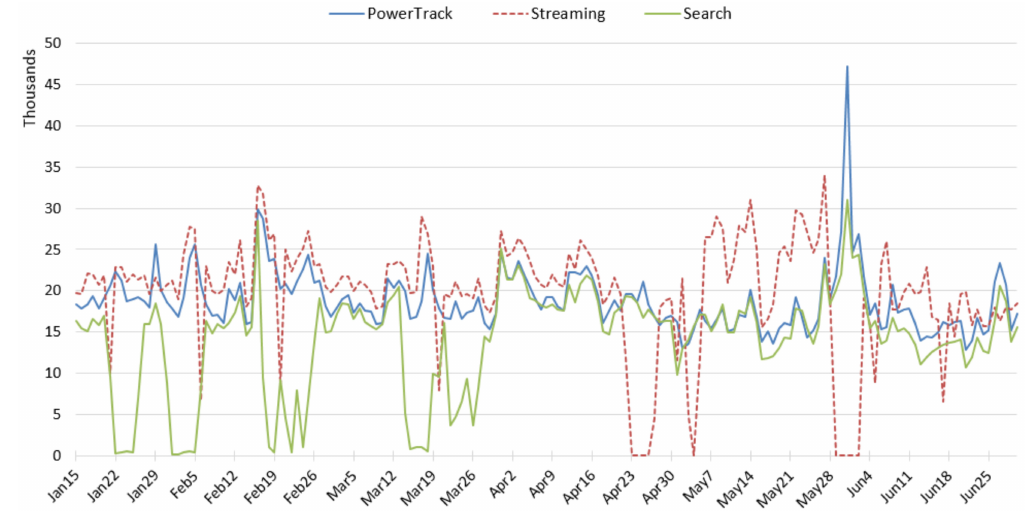
Figure 2. Daily amount of tobacco-related tweets across the